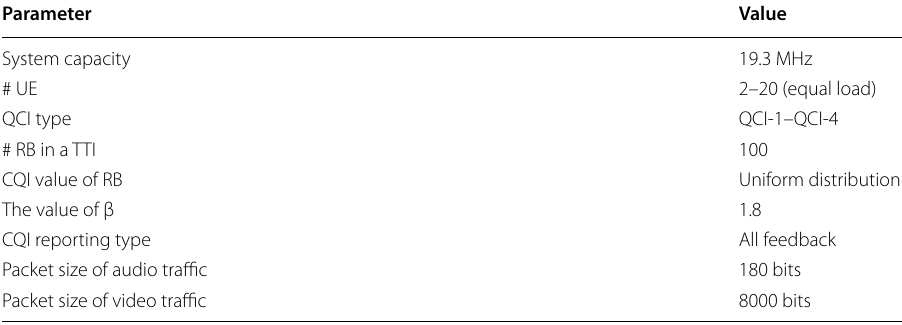
Table 2 Simulation